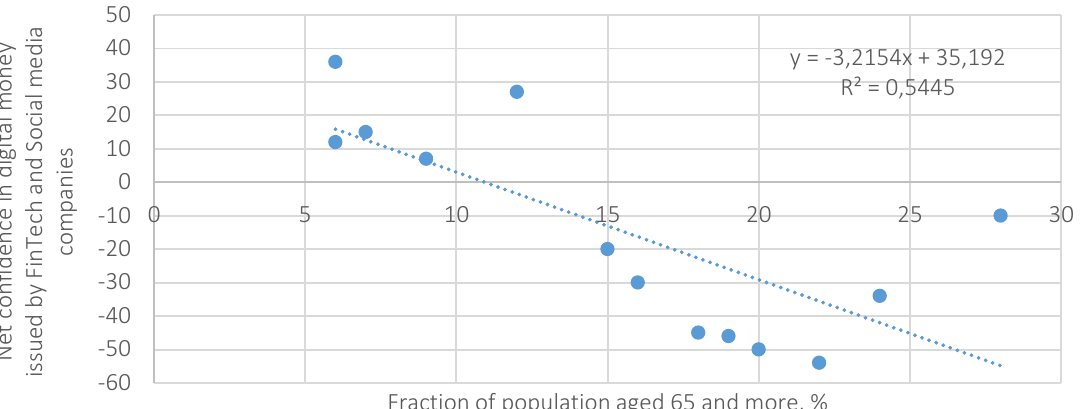
Figure Е6. Confidence in privately issued digital money and the fraction of older